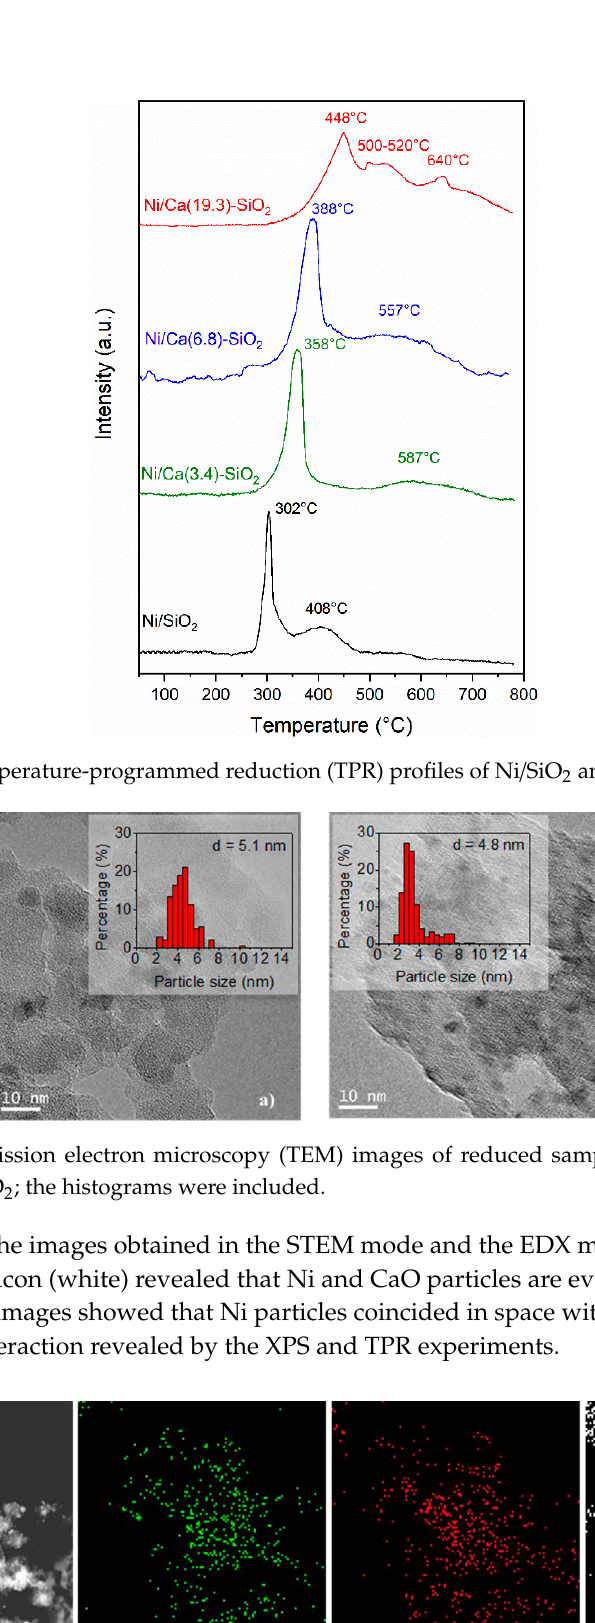
Figure 6. Selected area for the EDX mapping in reduced Ni / Ca(19.3)-SiO 2 ; mapping of nickel (green), calcium (red), and silicon (white).